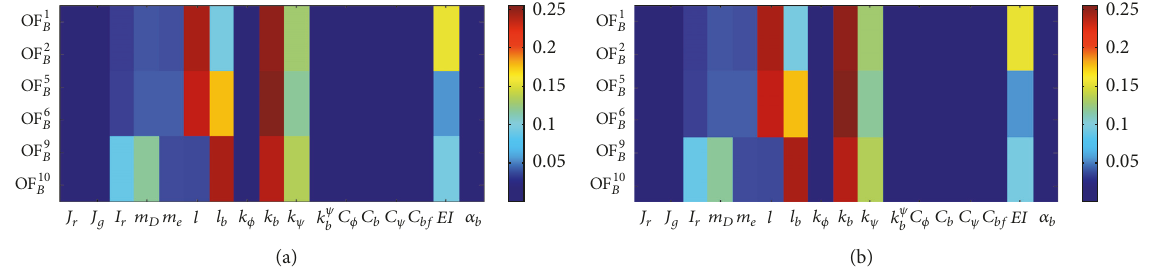
Figure 17: Primary sensitivity 𝑆 𝑖 (a) and total sensitivity ST 𝑖 (b) indices for bending model for ℎ res .